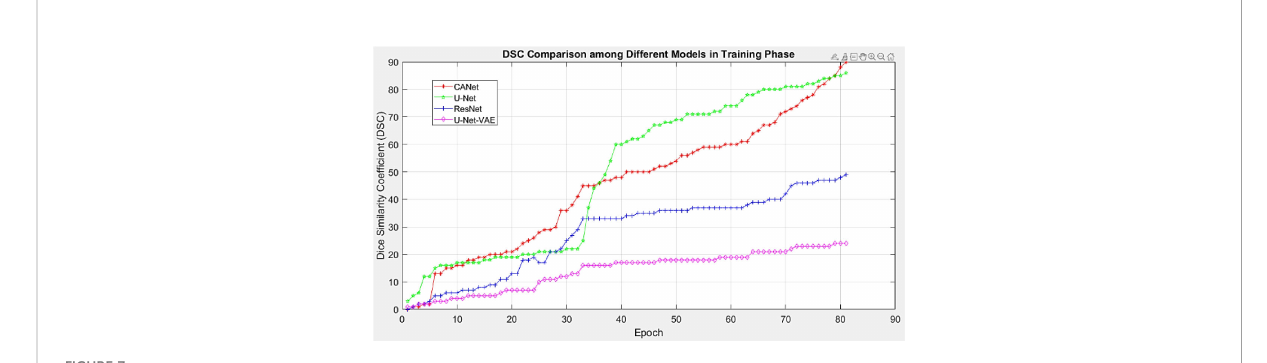
FIGURE 7 Proposed CANet CNN Model performance comparison using the DICE coef fi cient metric.